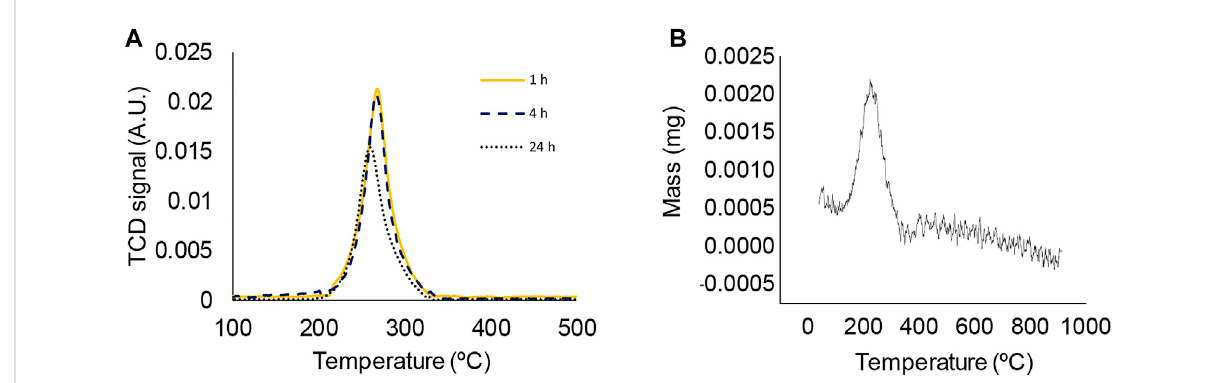
FIGURE 5 (A) TPOpro fi leofspentFe 3 O 4 catalystafterdifferentreactiontimes.Reaction conditions:T=300 ° C;CO 2 :H 2 Omoleratio=0.26;0.56 gFe 3 O 4 . Mass of spent catalyst employed in TPO analysis = 30 – 40 mg. (B) DTG analysis of the oxidation of fresh Fe 3 O 4 employing an intial mass of 10.4 mg Fe 3 O 4